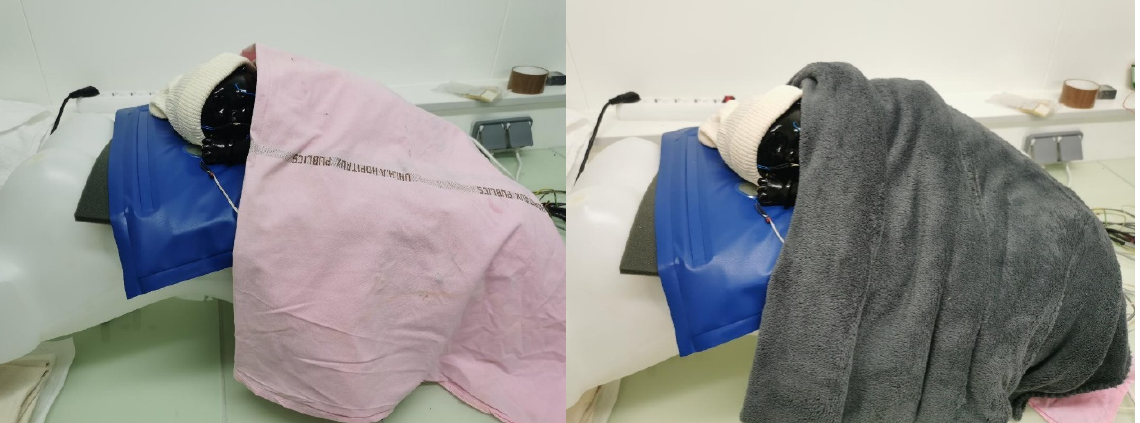
Figure 2. Photographs of the mannequin covered with a sheet ( left panel ) or a sheet + blanket set ( right panel ).